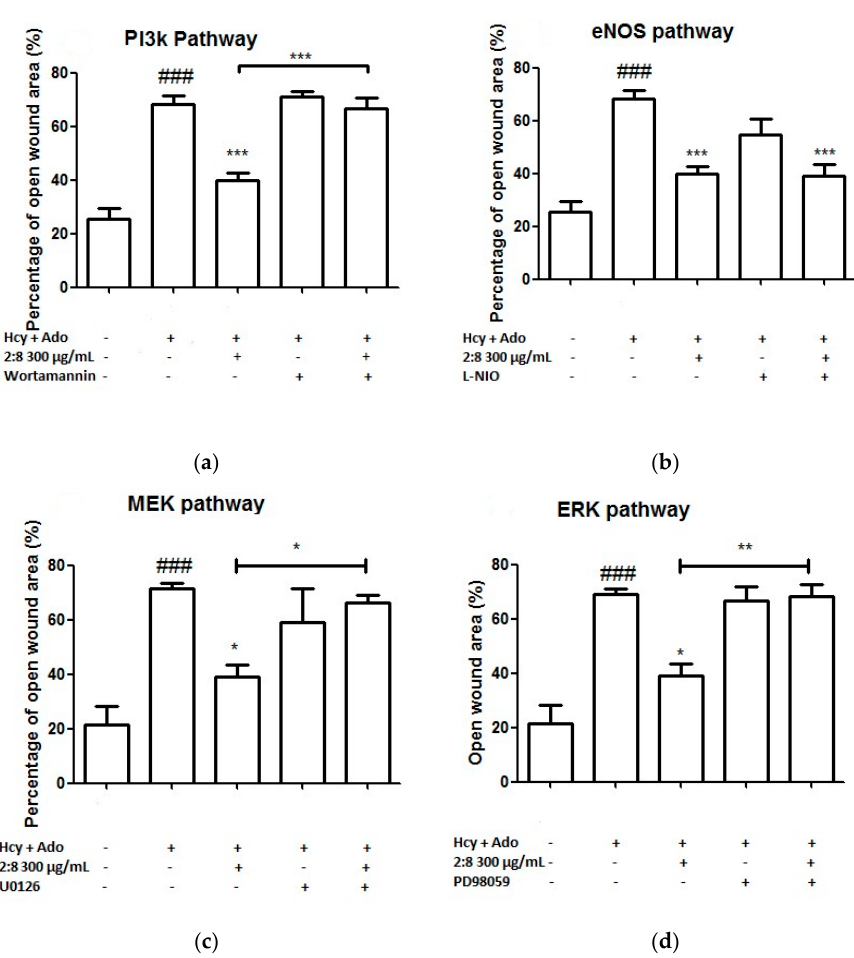
Figure 5. Effects of ( a ) wortmannin; ( b ) L-NIO dihydrochloride; ( c ) U0126 and ( d ) PD 98059 on EAhy926 cell growth affected by Hcy and Ado. EAhy926 cells were exposed to Hcy, Ado, DS-SQ 2:8 and/or each inhibitor for 24 h in serum-free medium after wound scratch. The open wound area before and after the treatment was analysed by TScratch software. The percentage of open wound area was calculated by: the percentage of open area at 24 h/the percentage of open area at 0 h × 100%. All results were expressed as mean ± S.E.M. from three separate experiments in triplicate. # p < 0.05 compared to control. * p < 0.05 compared to Hcy plus Ado treated group. ** p < 0.01 compared to Hcy and Ado treated group.